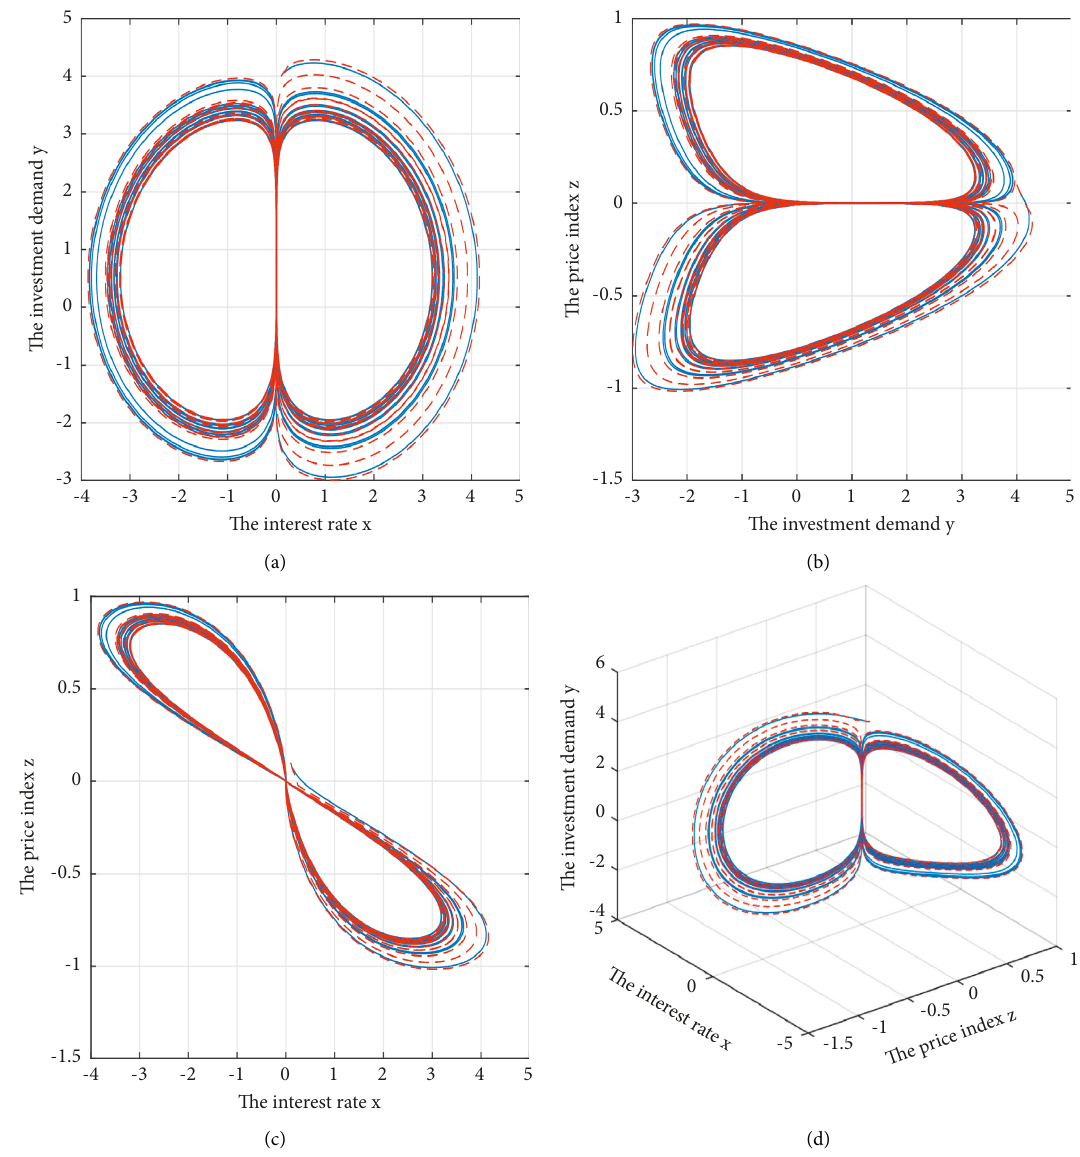
Figure 5: The phase portrait of the proposed model where (a) the demand of investment versus the rate of investment, (b) the index of price versus the demand of investment, (c) the index of price versus rate of investment, and (d) the chaotic behaviour of the system with the parameter values a � 1 . 0 , b � 0 . 2 ,c � 1 . 0, and ϑ � 0 . 9 to identify the influence of these input parameters on the chaos of the